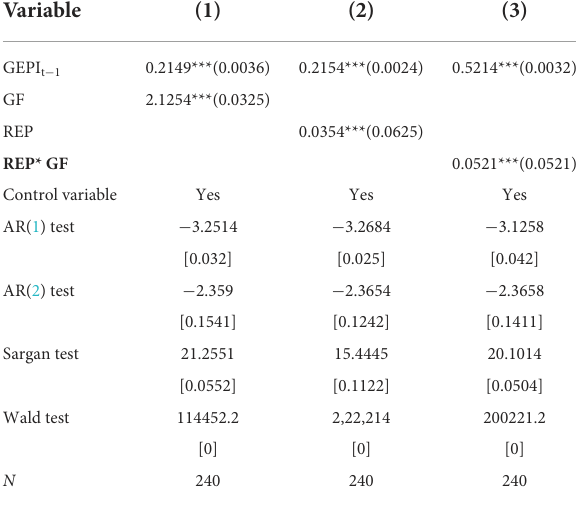
TABLE 6 Regression analysis of energy